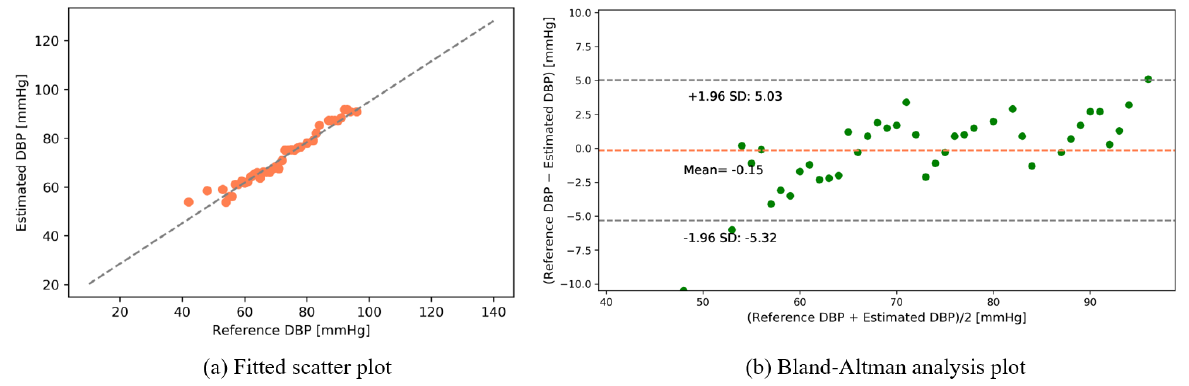
Figure 12. SBP estimation (public dataset).